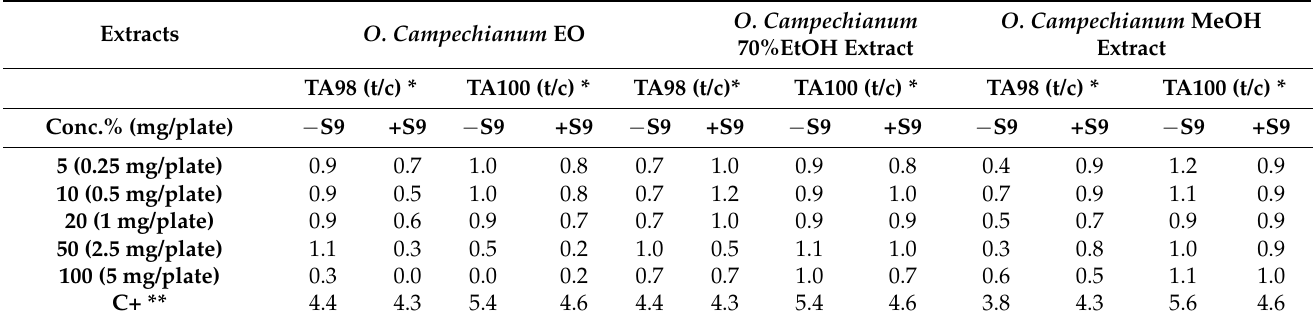
Table 6. Treated/control (t/c) ratio of colony count in the Ames